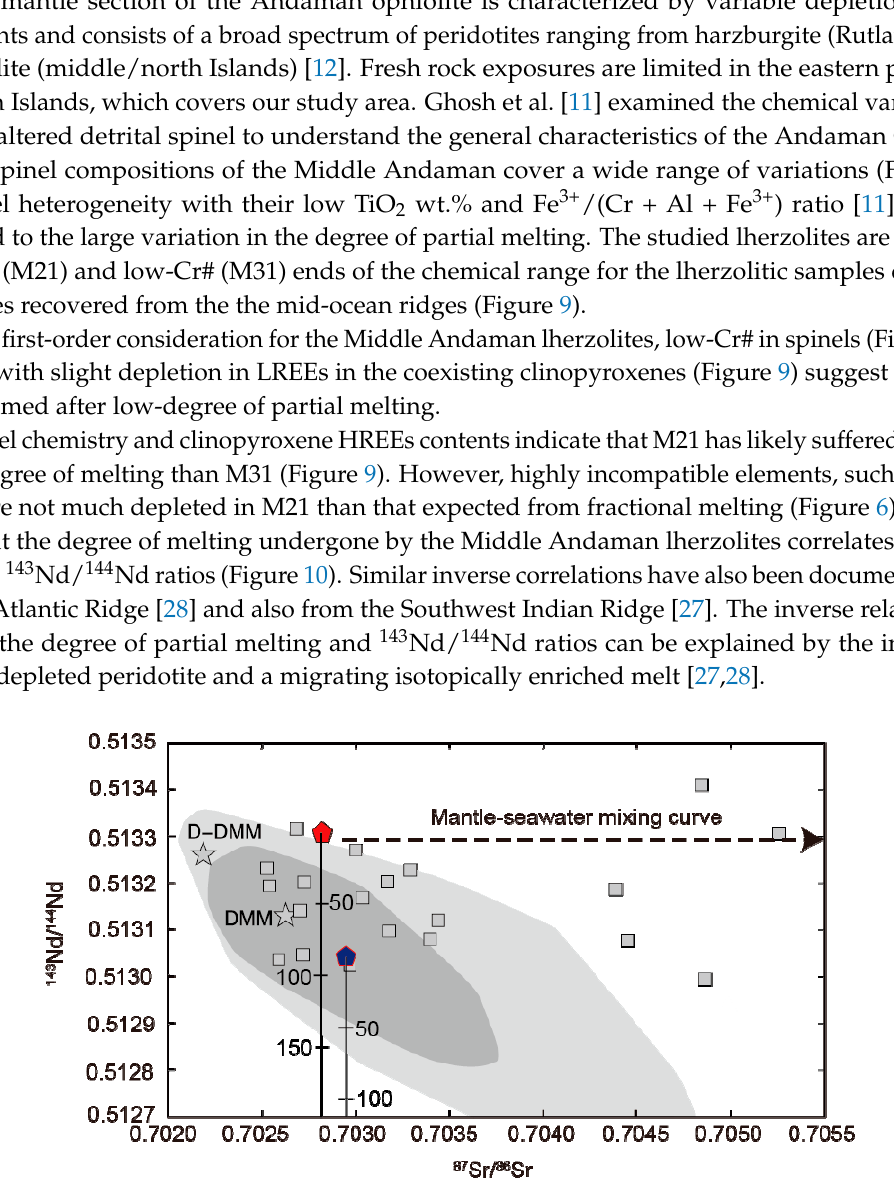
Figure 10. 143 Nd/ 144 Nd- 87 Sr/ 86 Sr isotopic compositions of clinopyroxene in the Middole Andaman lherzolites. The compositional ranges for mid-ocean ridge basalts (MORB) and peridotites (light grey square) are from [27]. The dark gray area (MORB*) is a compositional range with a higher density among the MORB data. The DMM and D-DMM values are from [29,30], respectively. Mantle-seawater mixing curve (broken arrow) is referred from [28].